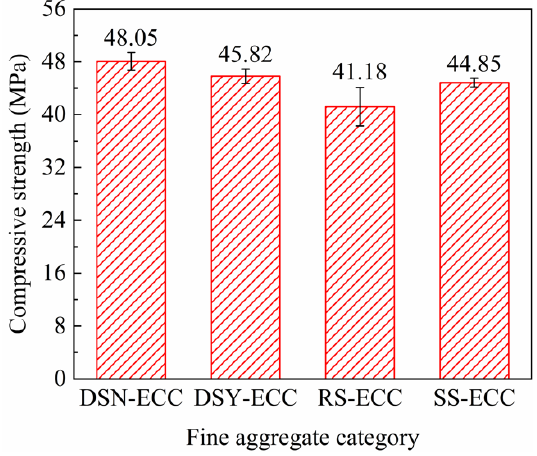
Figure 4. Relationship between fine aggregate category and compressive strength of ECC.